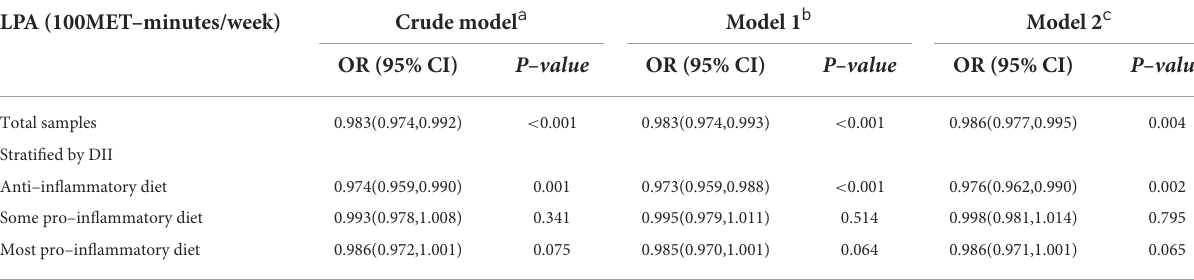
TABLE 3 Associations between leisure–time physical activity and depressive symptoms under different levels of DII.